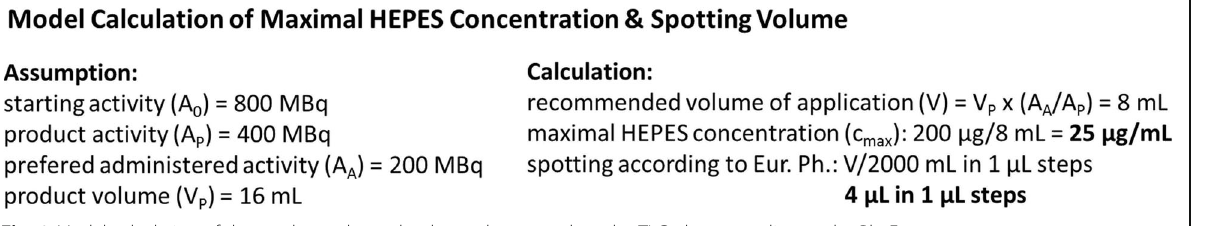
Fig. 2 Model calculation of the product volume that has to be spotted on the TLC plate according to the Ph.